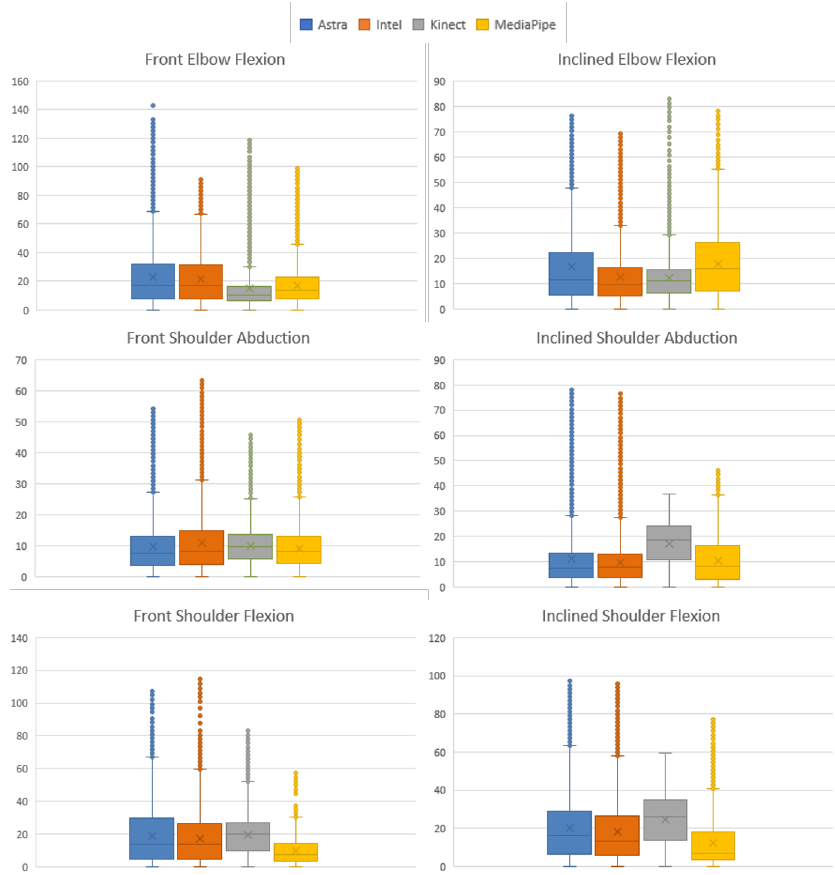
Figure 14. Grouped box plots of the absolute error (in degrees) of each UE movement.